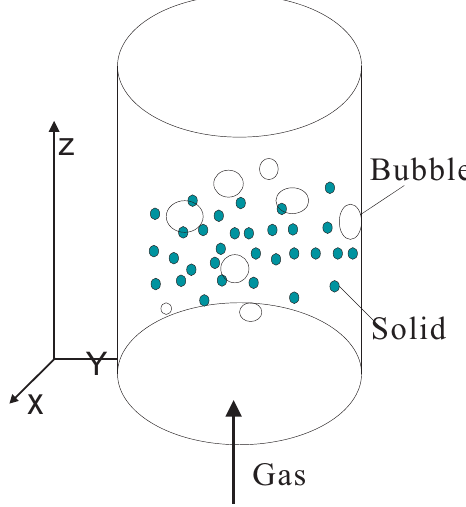
Figure 1. Schematic for the gas-solid two-phase